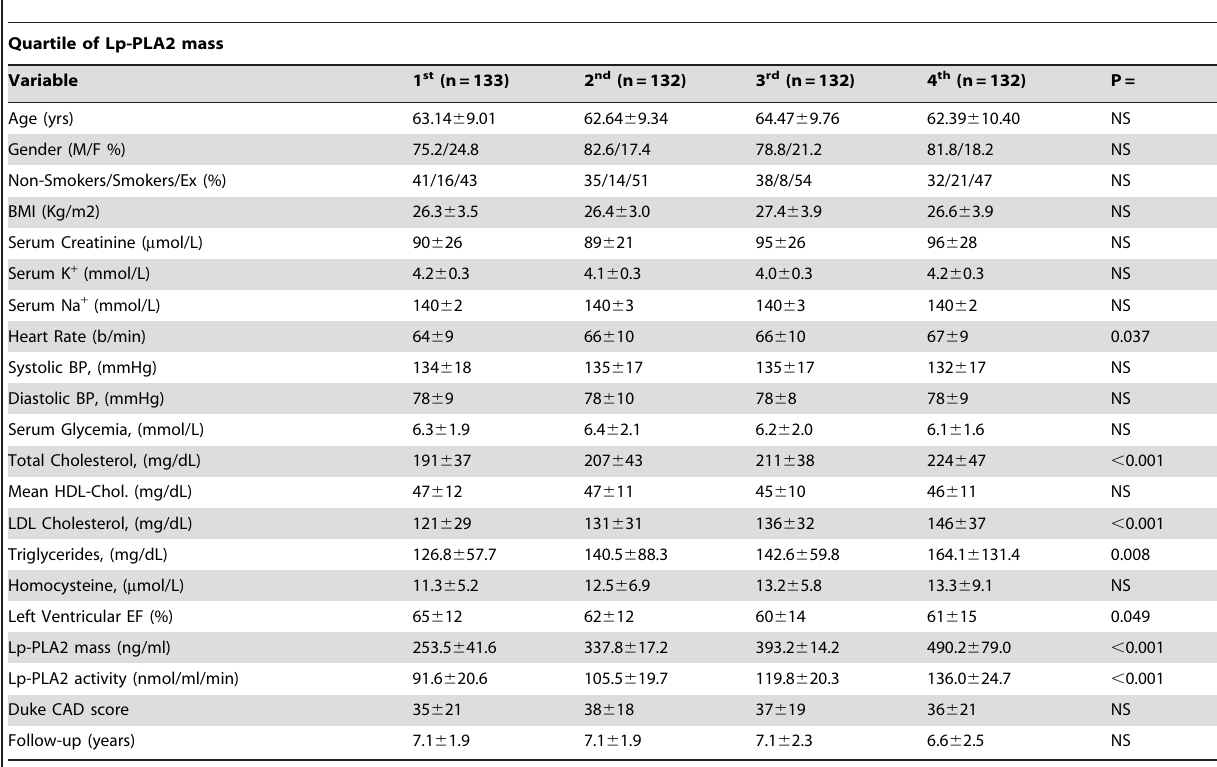
Table 1. Demographic and clinical characteristics of the subjects classified by Lp-PLA2 mass quartiles.